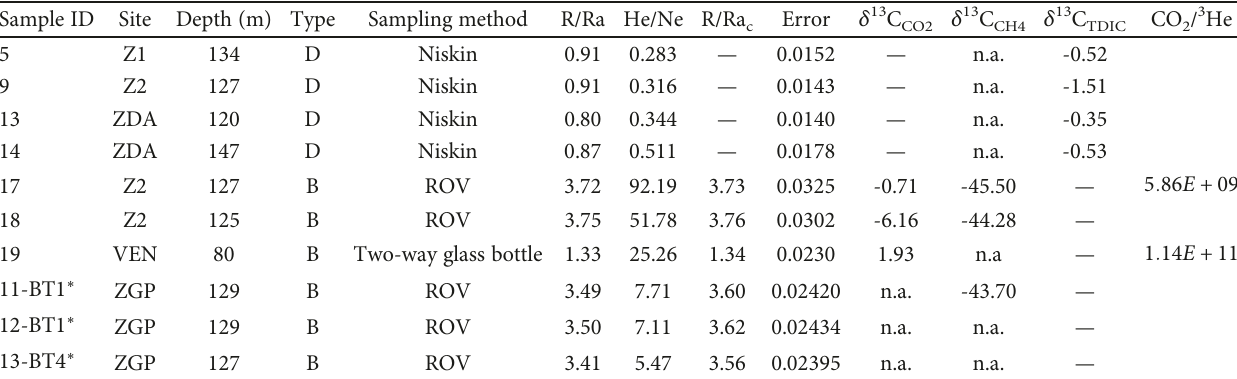
R/Ra c is the 3 He/ 4 He ratio corrected for the atmospheric contamination (see text for details). n.a. = not analyzed; ∗ Data and labels after Martorelli et al. [27].